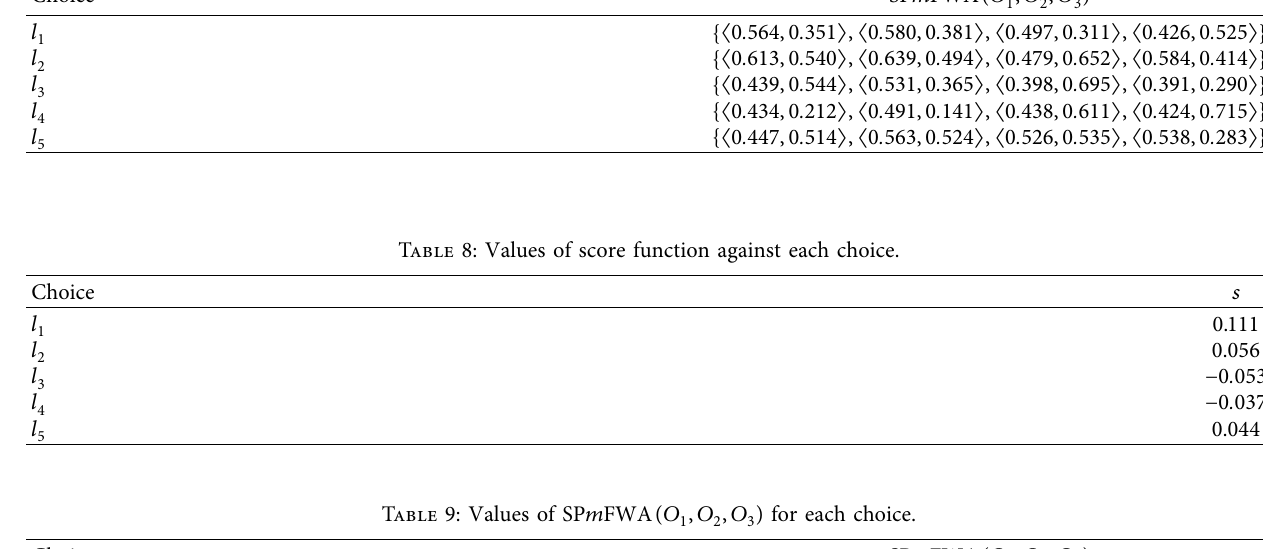
Table 7: Values of SP m FWA ( O